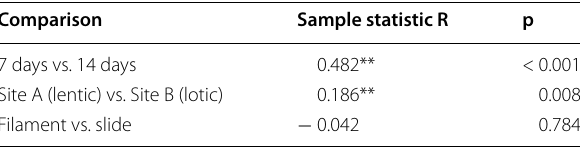
Table 3 Analysis of similarity (ANOSIM) comparisons for spatial, temporal and substrate differences in bacterial